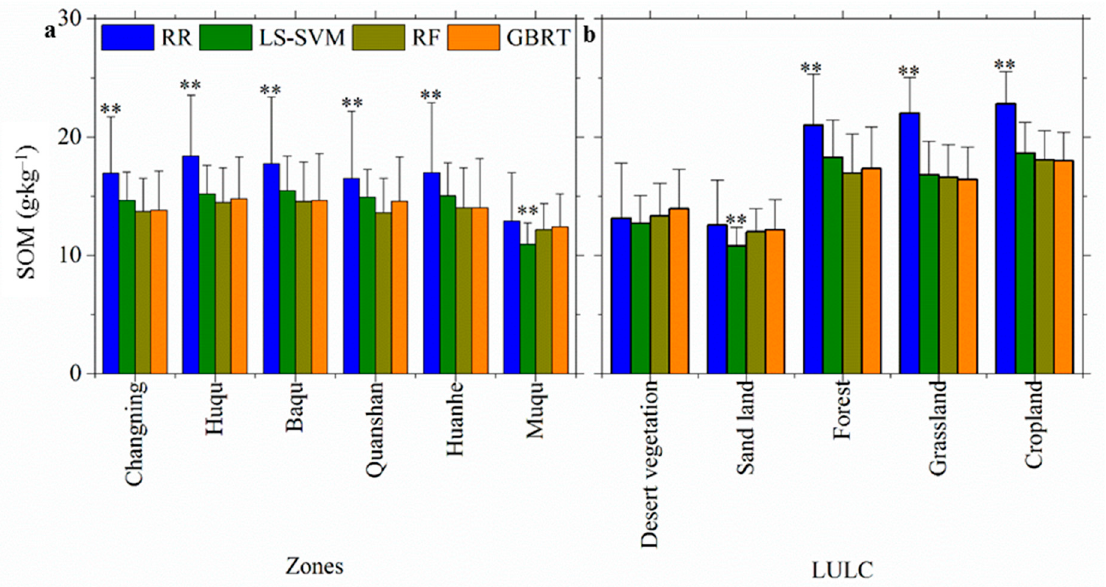
Figure 6. Statistics of SOM estimation results in the study area across different zones and various land use and cover types. Bars and error bars represent the average SOM and standard deviation. ** at the top of the bar signifies differences at 95% confidence levels relative to the RF estimation results. Zones of the study area include oasis regions (i.e., Changning, Huqu, Baqu, Quanshan, Huanhe) and a barren region (Muqu). The land use and cover types in the oasis regions include forest, grassland, and cropland, while desert vegetation and sand land are the major land use and cover types in the barren region. ( a ) zones; ( b ) lulc.